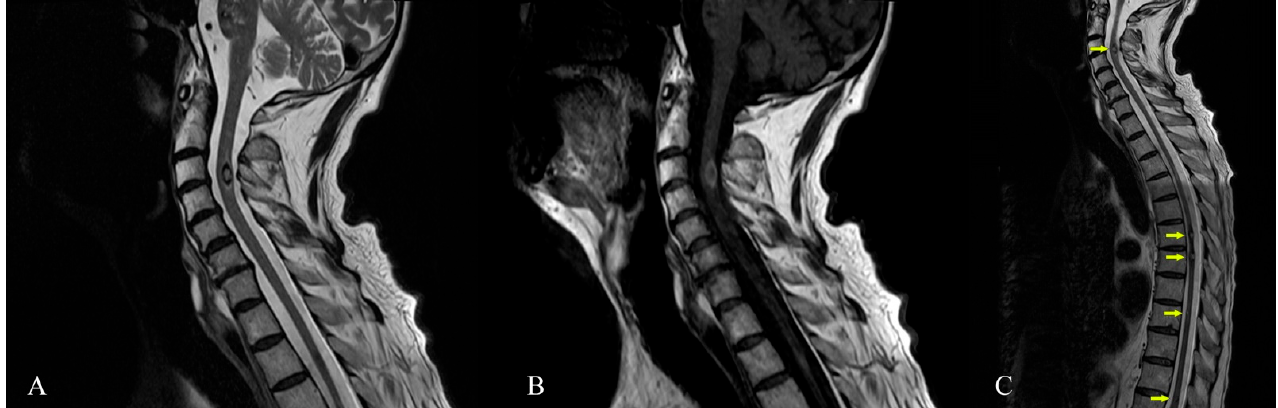
Figure 4. Cervical spine MRI (1.5 T)—January 2021. ( A ) Sagittal T2-TSE sequence showing intramedullary cavernoma at C3–C4 level with thin peripheral T2 hypointense ring—suggestive for gliotic sequelae changes secondary to a small bleeding cavernoma. ( B ) Sagittal T1-TSE intramedullary cavernoma at C3–C4 level ( C ) Cervical thoracic spine MRI, from January 2021, sagittal T2-TSE sequence showing focal lesions (arrows) with mixed-signal, located intramedullary at C3 level (dimensions